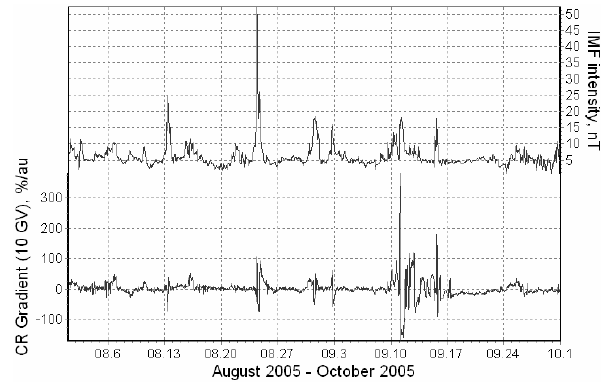
Fig. 5. The cosmic ray gradient calculated at 10GV (lower curve) and the IMF intensity (upper curve) are Figure 5: The cosmic ray gradient calculated at 10 GV (lower curve) and the IMF intensity (upper curve) are presented